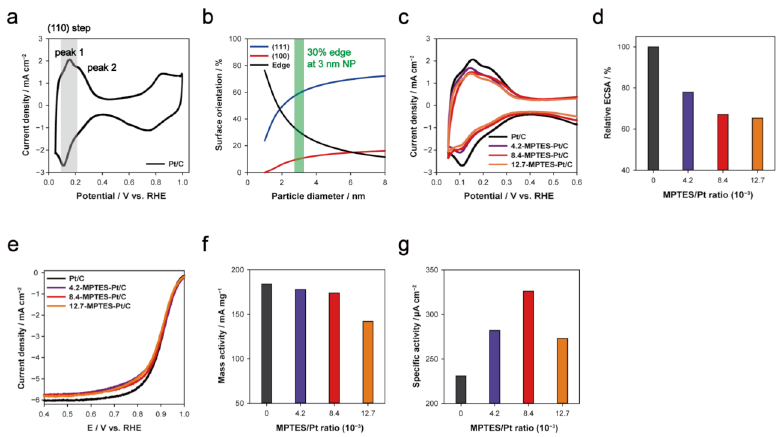
Figure 4. ( a ) Typical cyclic voltammetry (CV) curve of Pt/C. ( b ) Calculated surface atomic fractions of edge and vertex sites, (111) and (100) terrace sites for ideal cubo-octahedral Pt platinum nanoparticles (NPs) with various sizes, reproduced from [10]. ( c ) CV curves and ( d ) initial electrochemical surface area (ECSA) values for Pt/C and MPTES–Pt/Cs with different MPTES/Pt ratios. ( e ) Oxygen reduction reaction (ORR) polarization curves and comparison of ( f ) mass and ( g ) specific activity calculated from the kinetic current at 0.9 V for Pt/C and MPTES–Pt/Cs with different MPTES/Pt